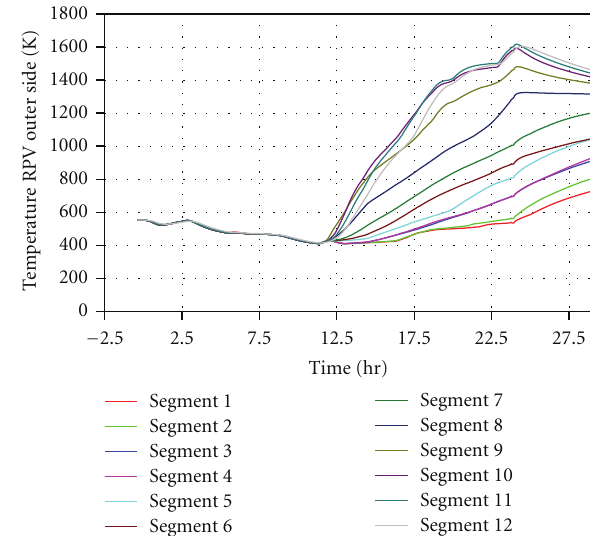
Figure 24: Temperature of RPV bottom wall at inner side.